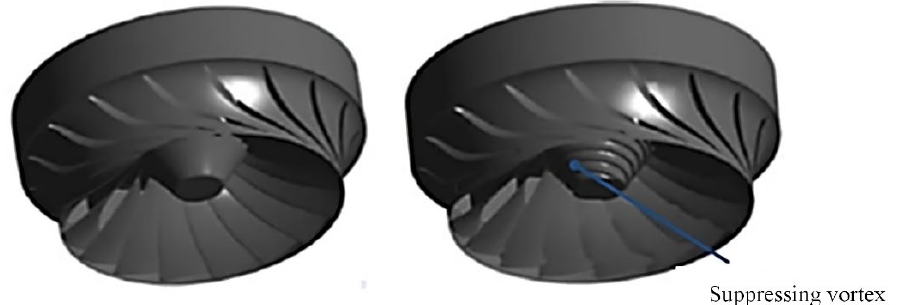
Figure 16. Physical drawing of runner cone [46].